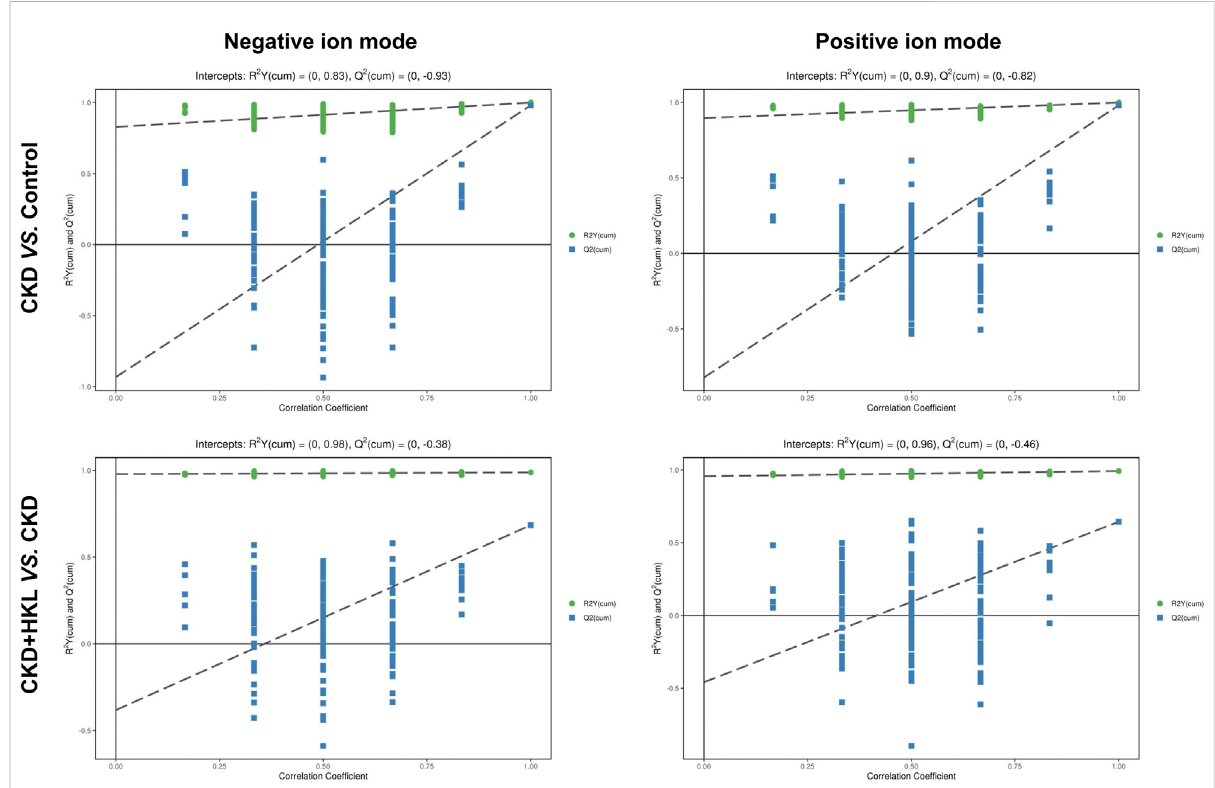
FIGURE 5 Permutation test of OPLS-DA. Permutation plots of OPLS-DA models for group CKD vs. control and group CKD + HKL vs. CKD in negative and positive ion